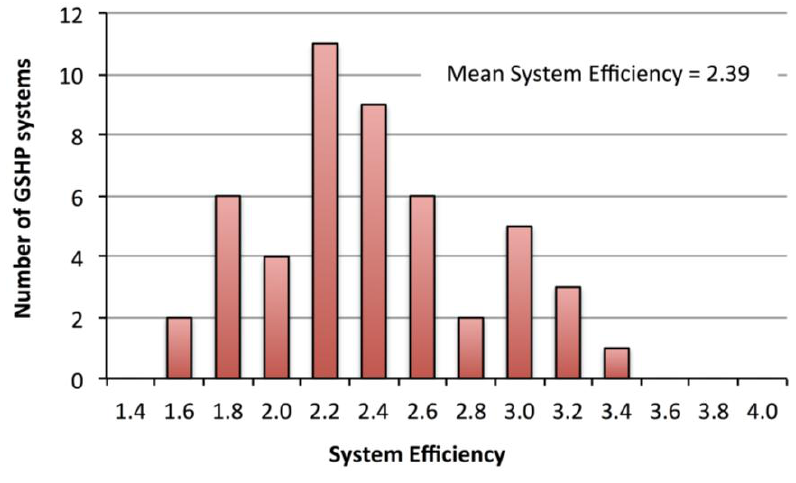
Figure 5. GSHP system efficiency (SPF pump field trials. Data from